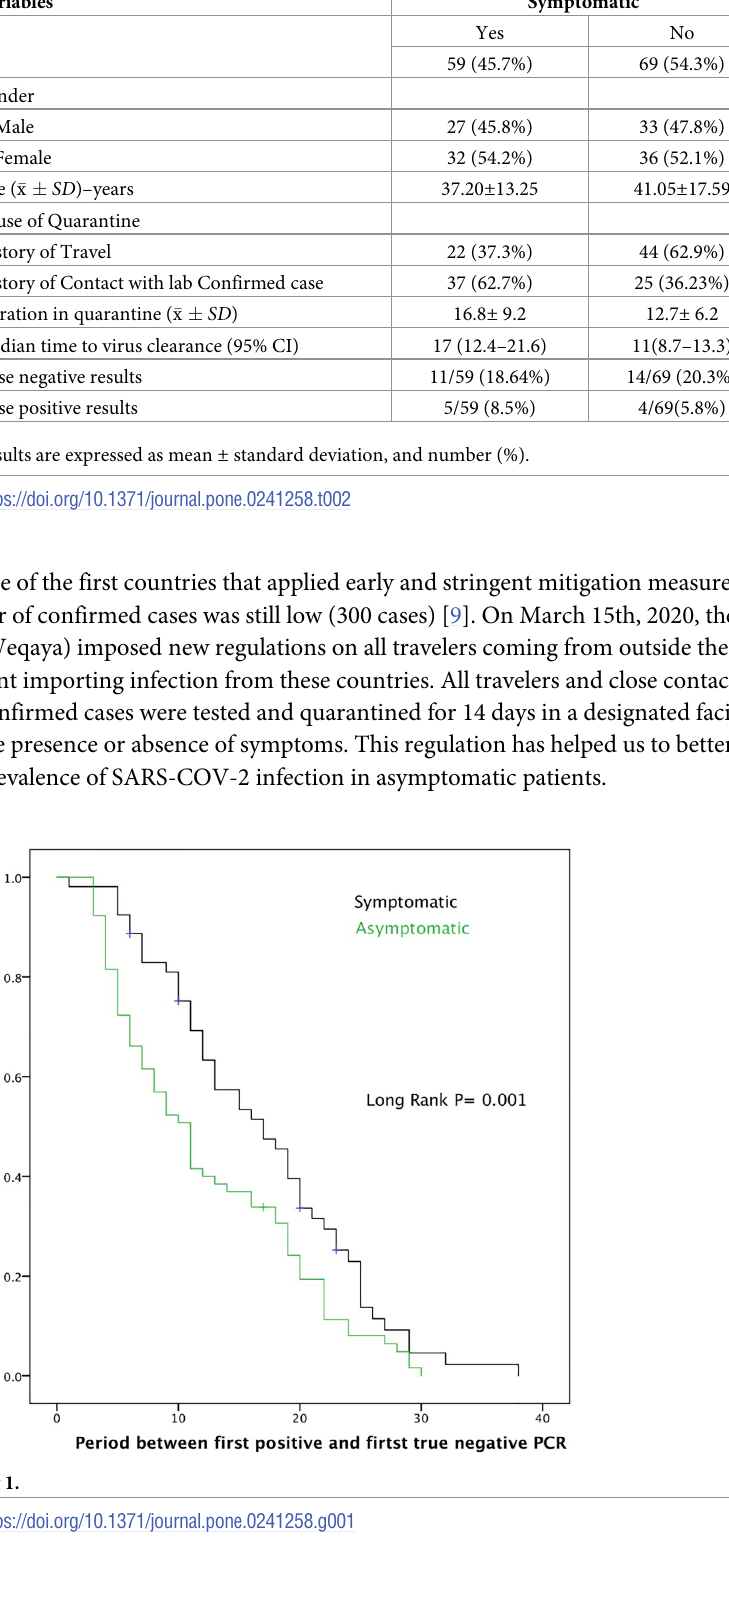
Table 2. Virus clearance and swab results with demographic data of the patients.